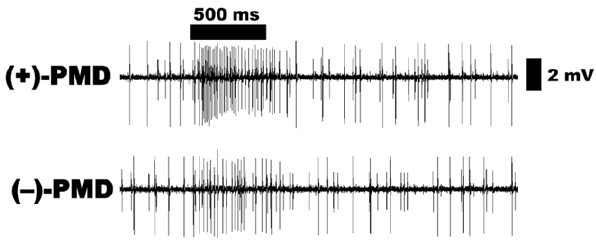
Figure 7. Repellent-sensitive ORN, pb1A, challenged with PMD stereoisomers. ( + )-PMD elicited higher response from the large spike neuron than ( 2 )-PMD. Source dose, 100 m g.